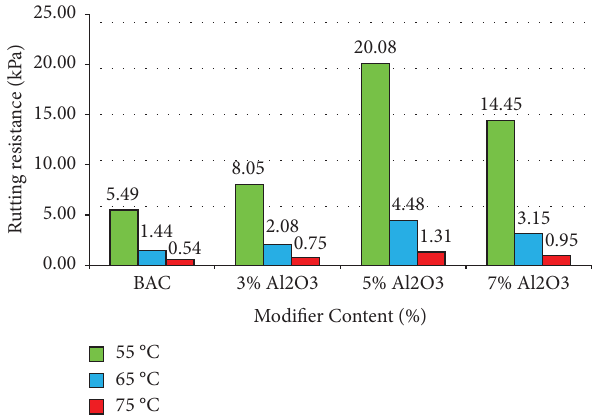
Figure 7: Te efects of rutting on base and modifed binders.